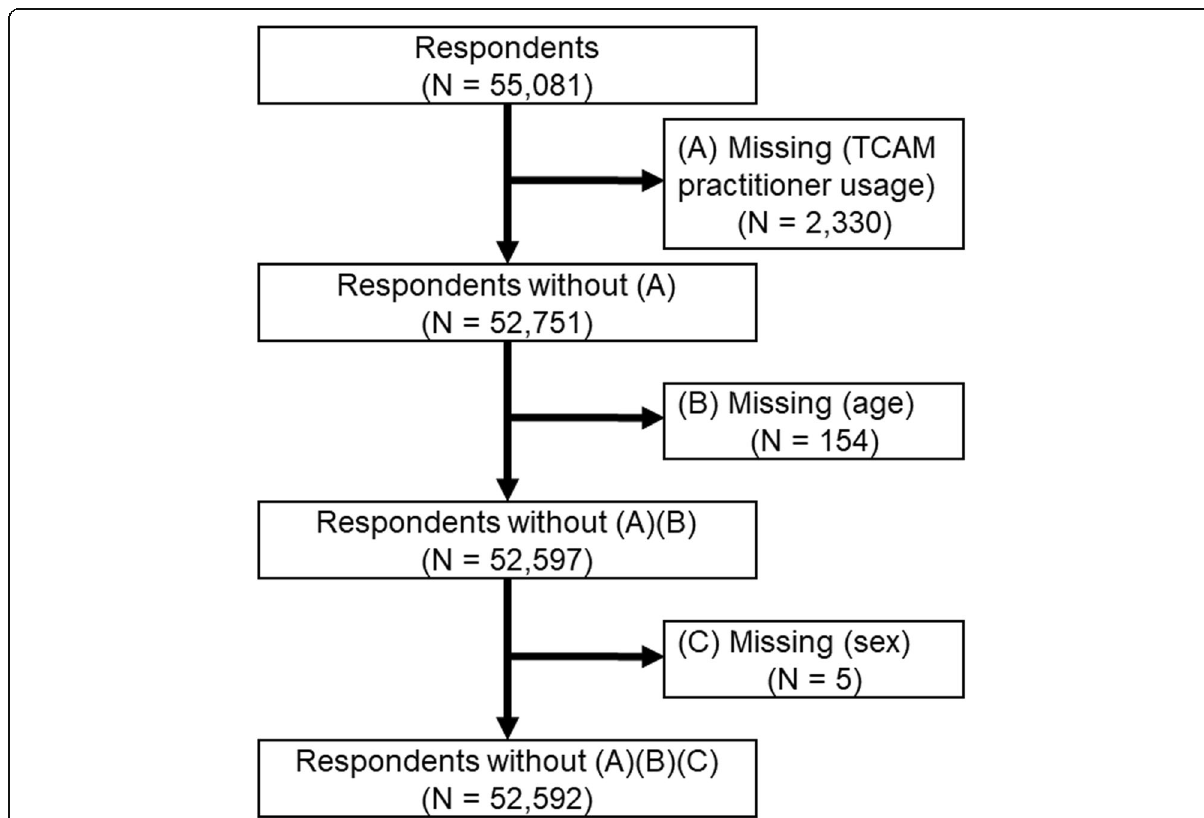
Fig. 1 The flowchart of the process of TCAM practitioner usage, age and gender excluded. Samples with missing information on TCAM practitioner usage, age and sex variables were excluded. Finally, 52,592 samples were